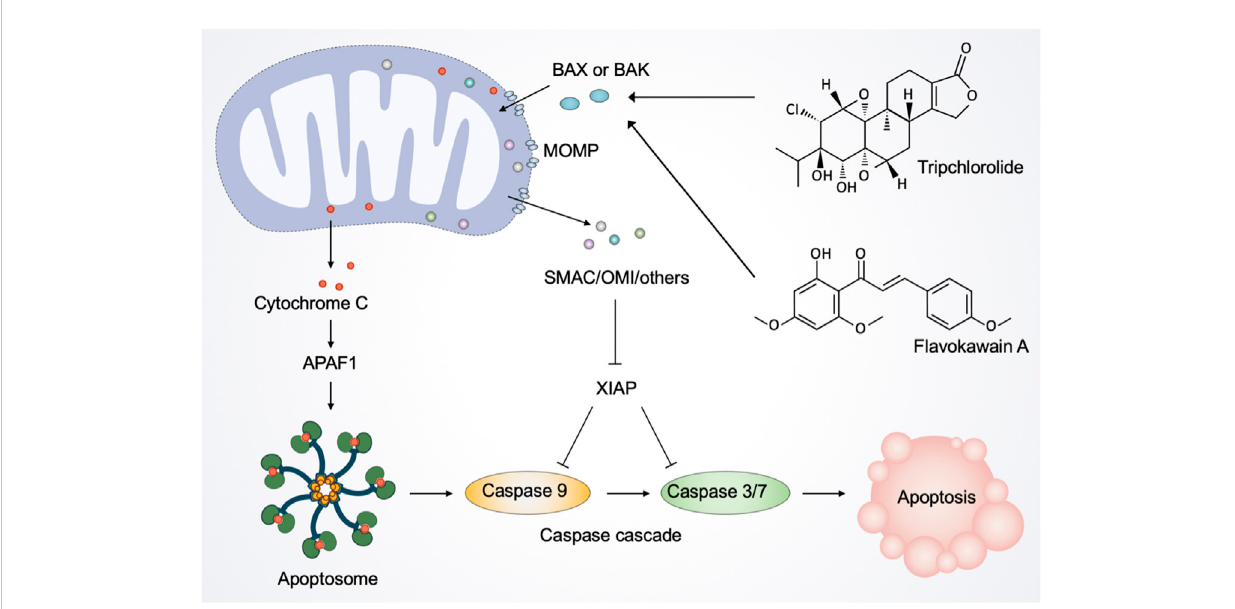
FIGURE 6 Natural products regulate mitochondria in apoptotic cell death. The activated pro-apoptotic effector, such as Bax and Bak, induce mitochondrial outer membrane permeabilization (MOMP). After the activation of MOMP, mitochondrial intermembrane space proteins, notably cytochrome C, are released into the cytosol. Once released, cytochrome C binds to the adaptor molecule APAF1 (apoptotic peptidase activating factor 1) to form a heptameric structure called apoptosome. Subsequently, apoptosome recruits and activates the initiator caspase 9, which in turn cleaves and activatescaspase3andcaspase7,leadingtotheexecutionofapoptosis.Moreover,MOMPreleasesotherproteins,includingSMACandOMI,toinhibitthe caspase inhibitor XIAP (X-linked inhibitor-of-apoptosis protein), thereby facilitating apoptosis. Natural products such as tripchlorolide and fl avokawain A promote the translocation of Bax from the cytosol to mitochondria and the release of cytochrome C into the cytosol, thereby activating the mitochondrion-mediated apoptotic